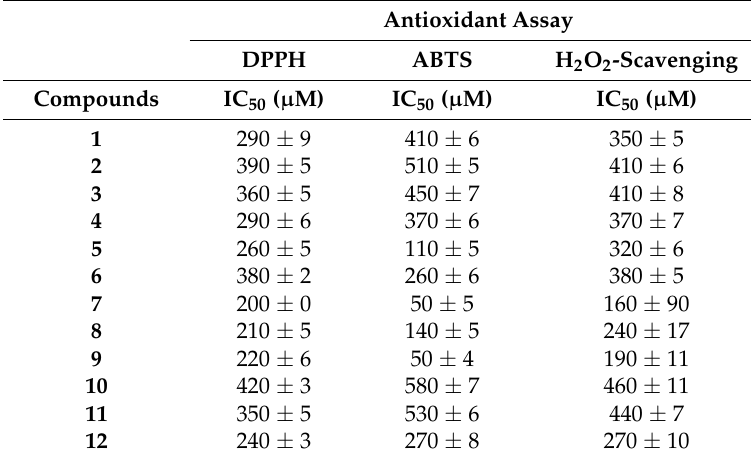
Table 4. Scavenging activity of Compounds 1 – 12